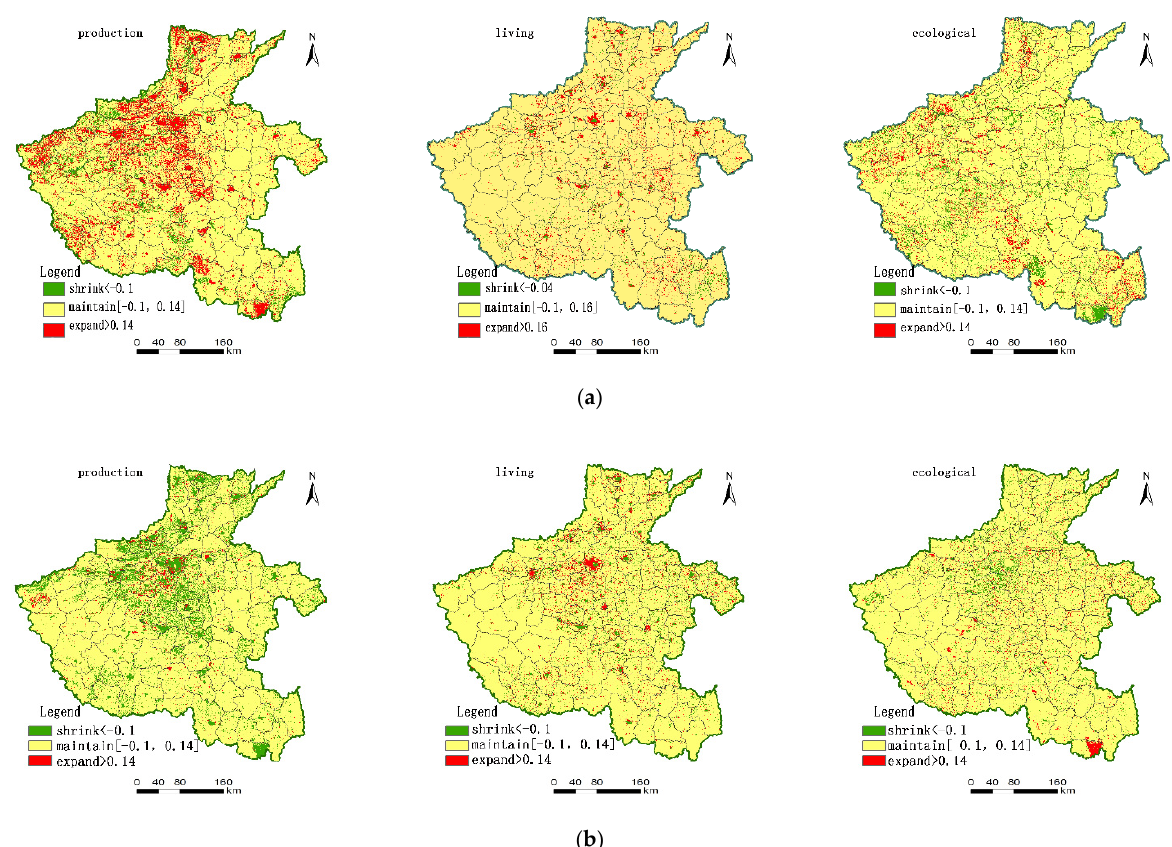
Figure 4. Changes of PLE functions of territory space in Henan Province. ( a ) Changes of functions from 1990 to 2005; ( b ) changes of functions from 2005 to 2018.